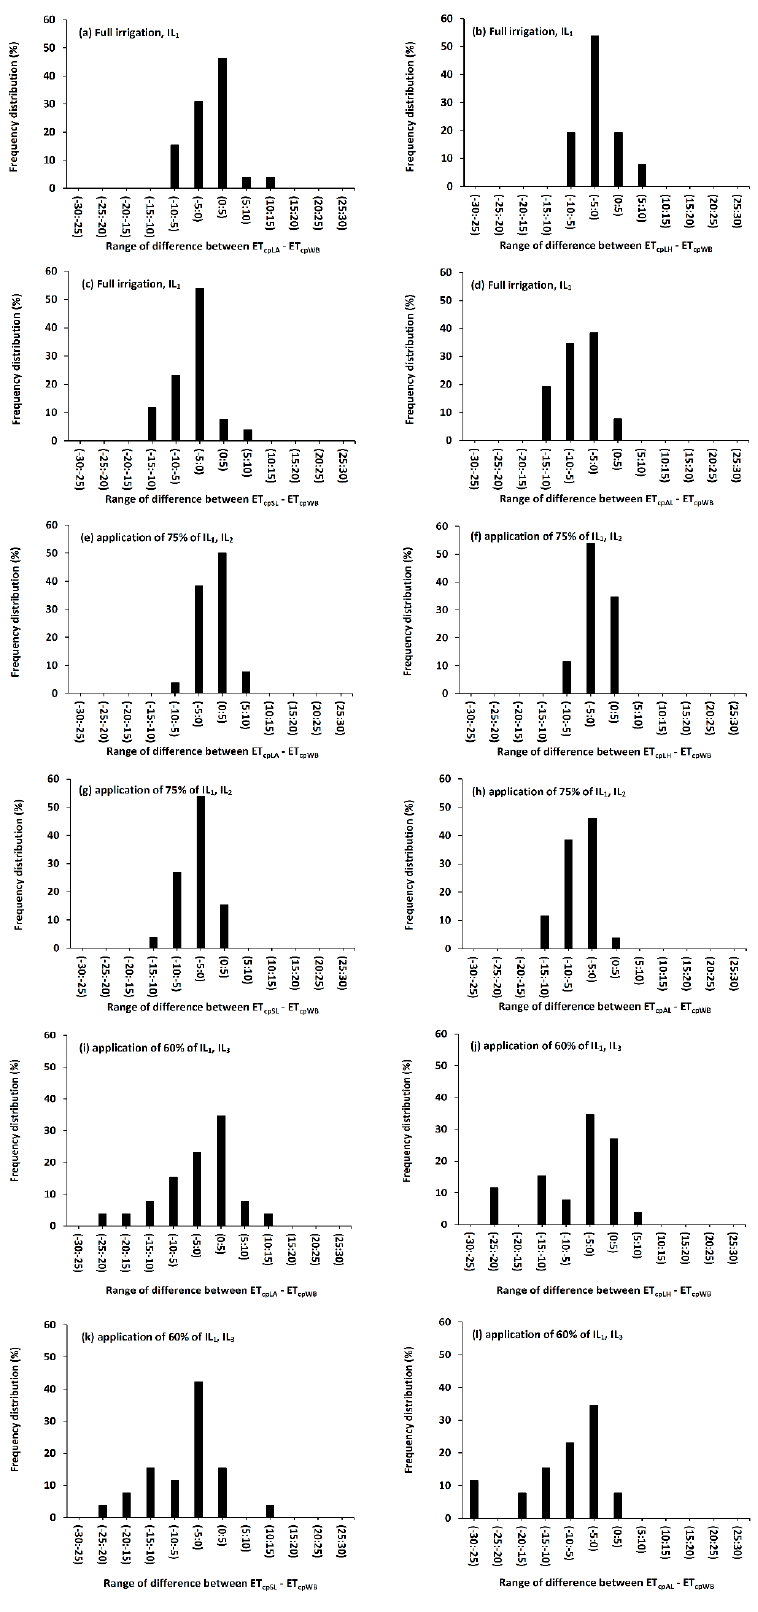
Figure 9. Frequency distribution of daily range difference between ET cp estimated according to the four empirical canopy resistance approaches on a potato crop under IL 1 ( a – d ), IL 2 ( e – h ) and IL 3 ( i – l ) irrigation levels and obtained by soil water balance ( ET cpWP ) for both evaluated